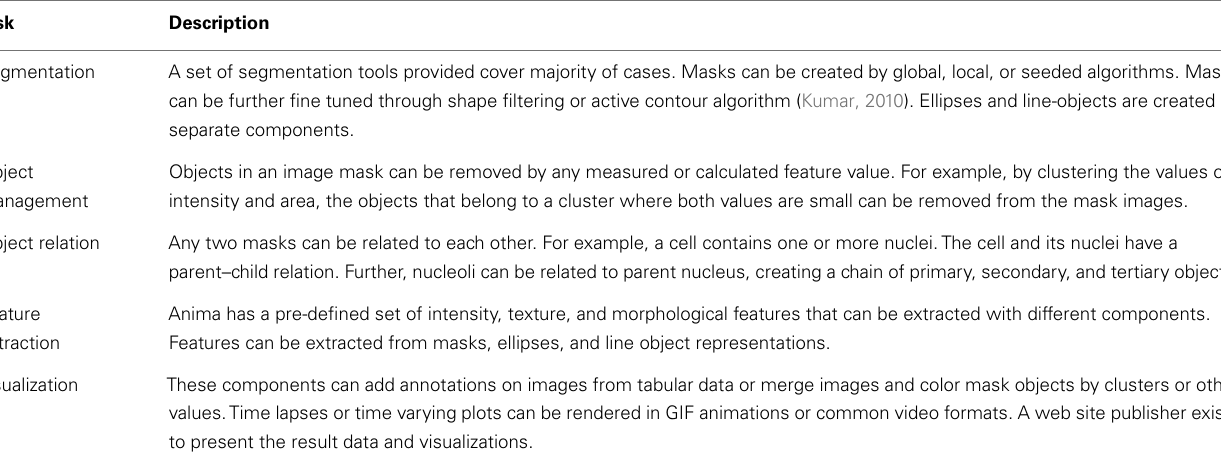
Table 1 | Component categories and their applications in theAnima bundle .